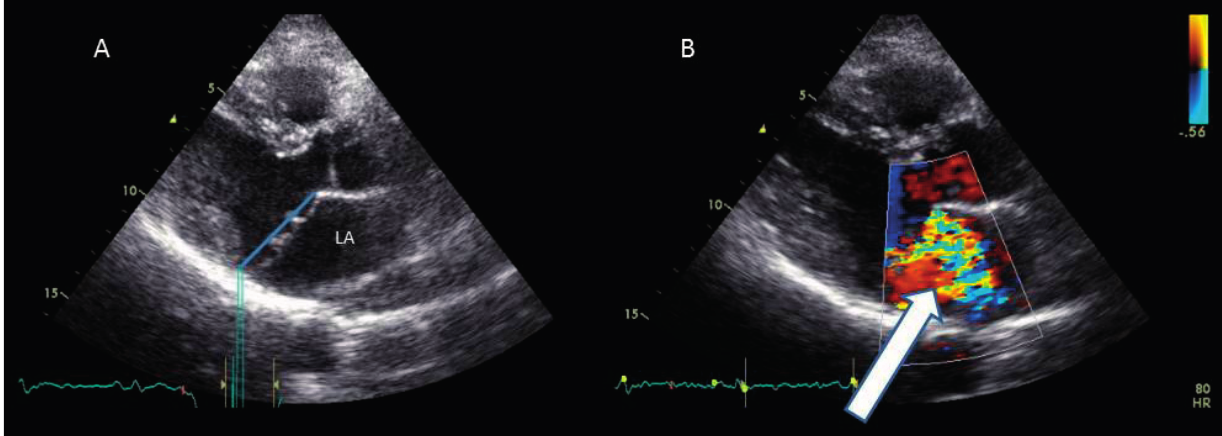
Figure 2. A parasternal long axis view of a prolapsing valve. Panel A shows the prolapsing valve relative to the annular line ( blue line ). Panel B shows color Doppler through the prolapsing valve demonstrating a severe jet of regurgitation ( arrow ). LA = left